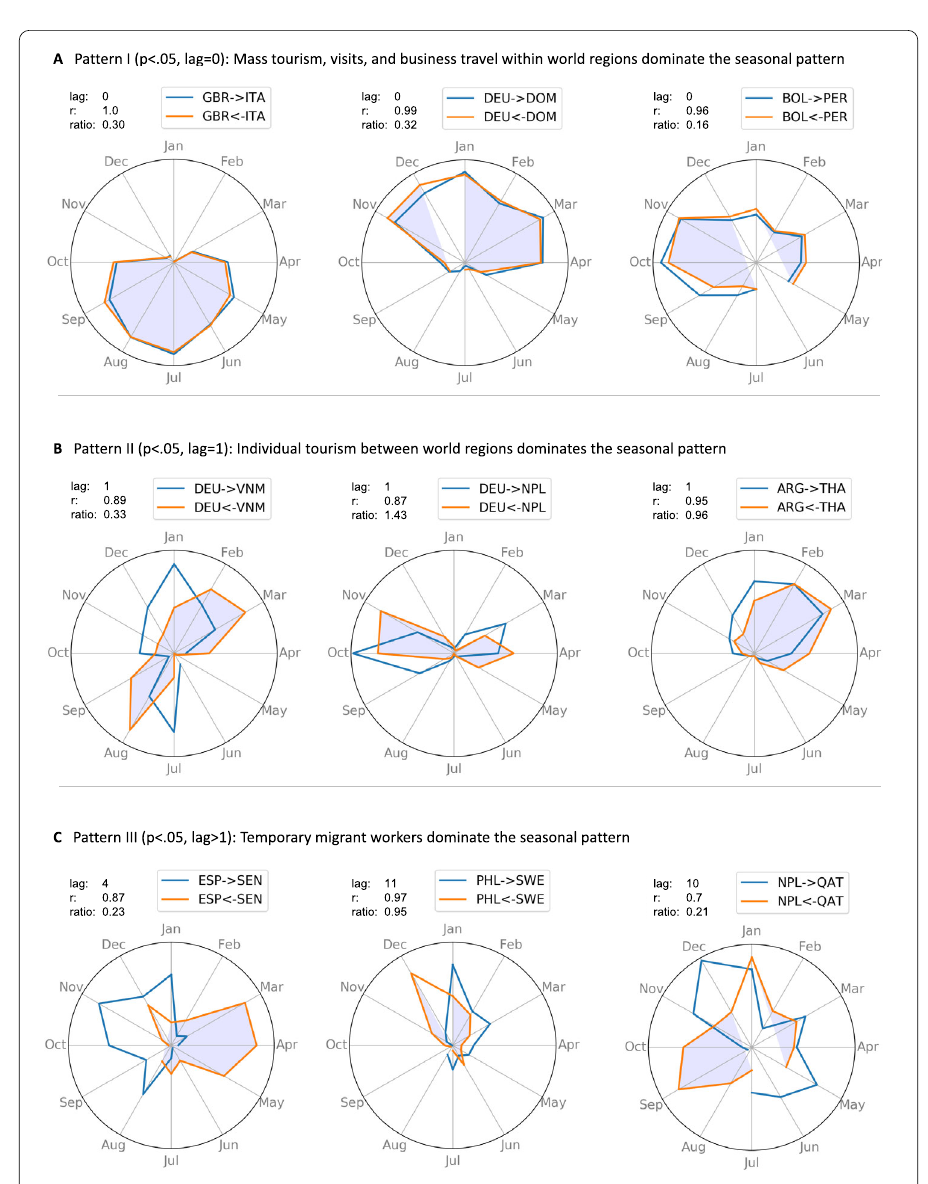
Figure 9 Three seasonal patterns with three example cases each. Based on the cross-correlations ( r ) between the seasonal patterns from A to B and from B to A . The classification into the three patterns depends on the significance of r and the degree of (a-)synchronicity (lag in months). The peak ratio allows to get an understanding of the importance of the seasonal component relative to all mobility occurring between the two countries in question. The unambiguous denotation of lags ( e.g. , “4” instead of “4/6”) is based on the interpretations of the movements with the aid of external information as described in the text. For a list of country-code abbreviations, please see the end of the article